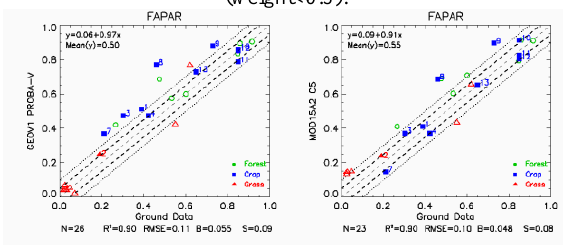
Figure 13: As in Figure 12 for FAPAR.